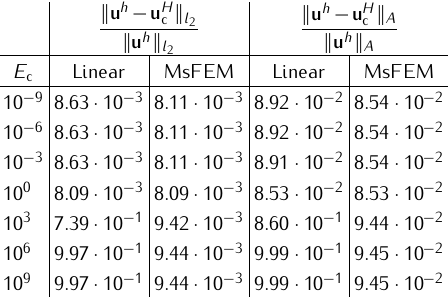
Table 8. Approximation of fine-scale solution by linear and MsFEM coarse space for Medium 1; geometry: